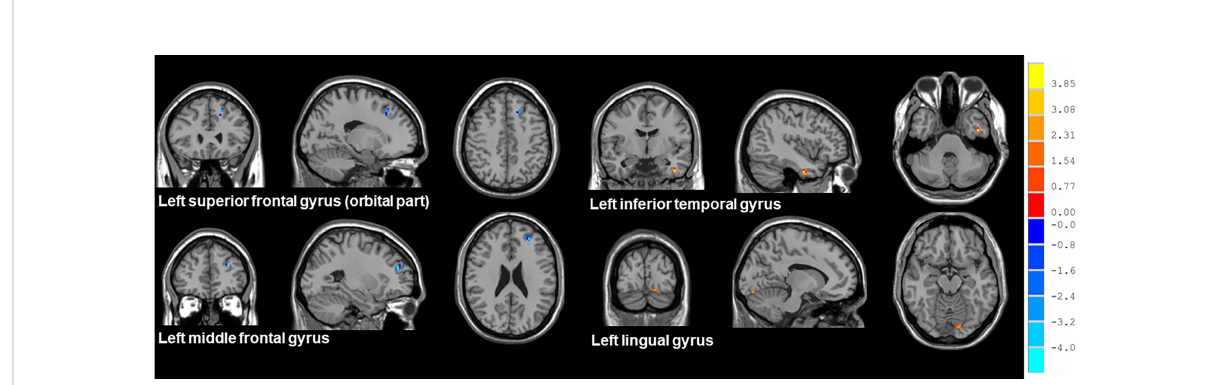
FIGURE 4 Brain regions showed altered ReHo values between NSCLC patients received pemetrexed plus carboplatin chemotherapy and paclitaxel plus carboplatin chemotherapy. NSCLC: non-small cell lung cancer; HCs: healthy controls. ReHo: regional homogeneity. The results were obtained by two-sample t -tests. The signi fi cance threshold was set at P <0.001 and were corrected for multiple comparisons using the AlphaSim program with a minimum cluster size of 6 voxels (two tailed).